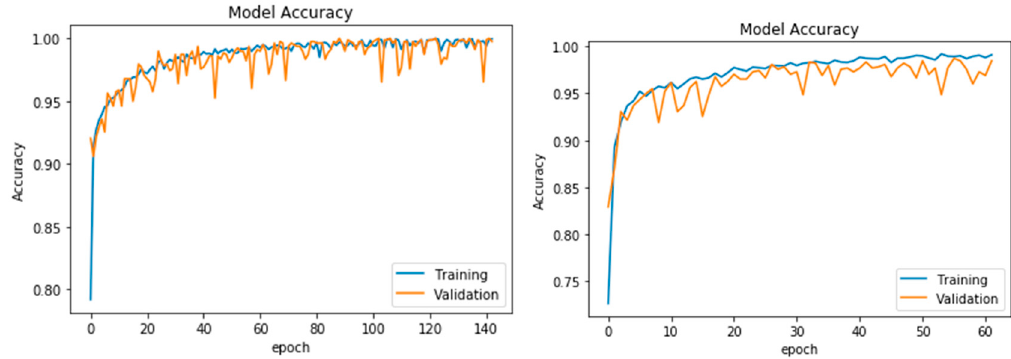
Figure 8. Training and validation accuracy curve without dropout when fusing DSM and RGB ( left ), and loss of information with RGB only ( right ) without dropout.